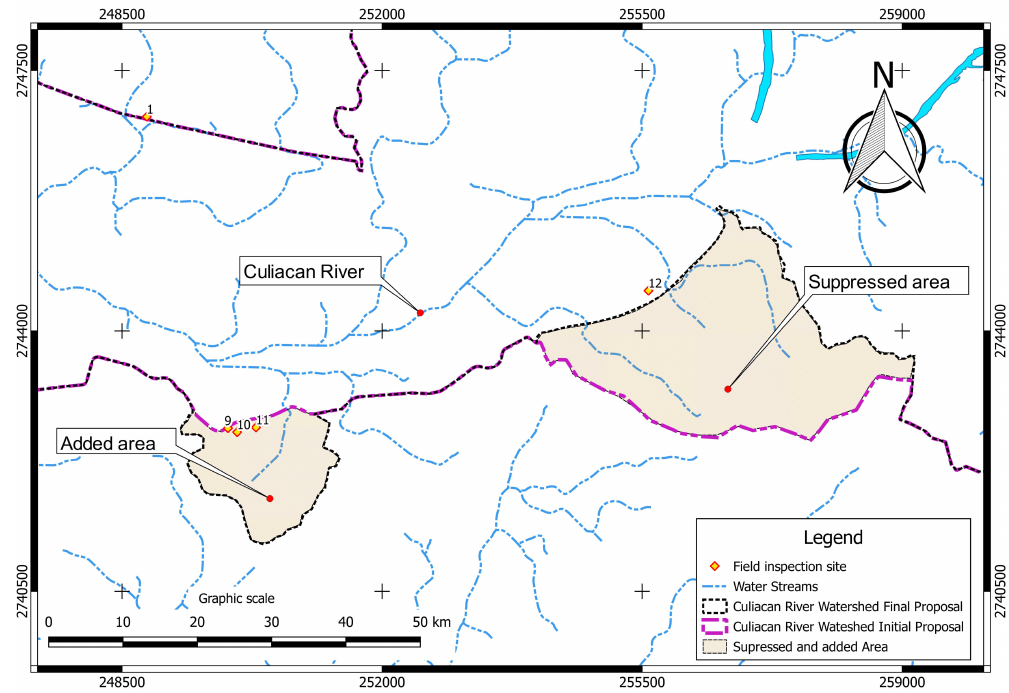
Figure 10. Culiacan River drainage divide, including the urban and agricultural infrastructure in the study